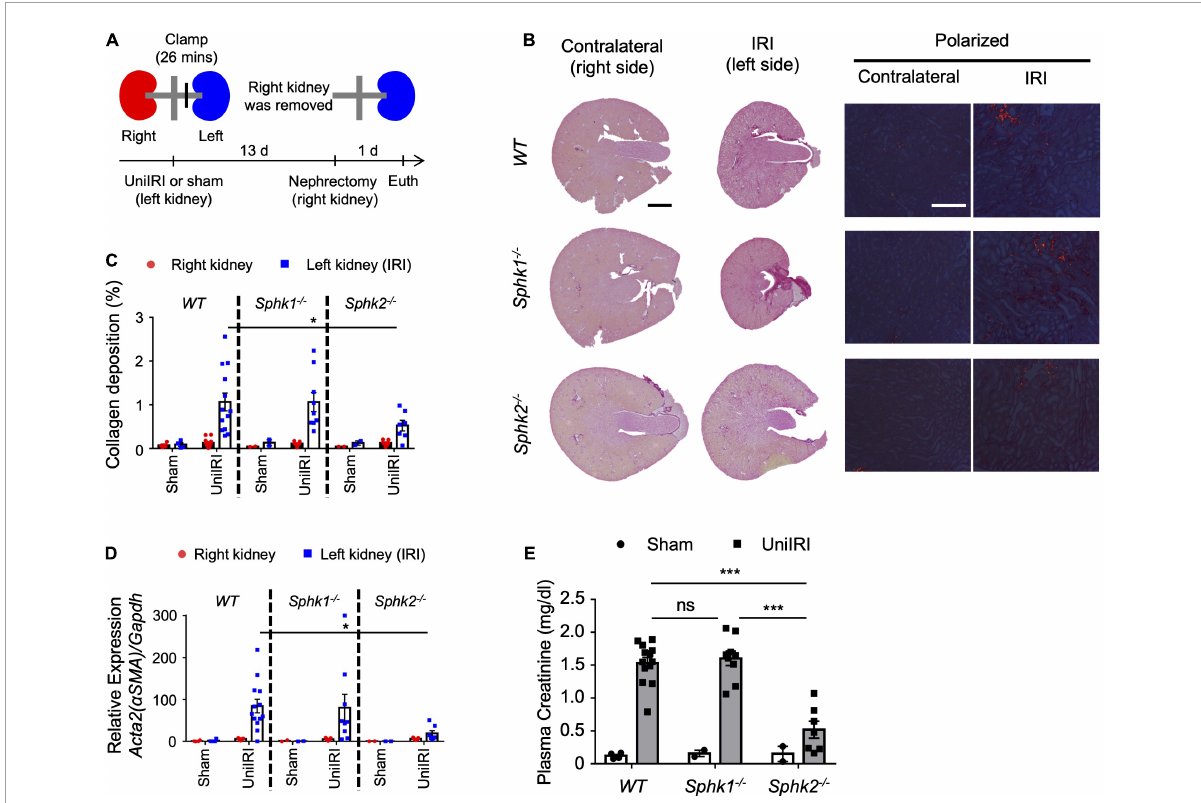
FIGURE1 Sphk2-deficient mice develop less renal fibrosis. (A) Experimental plan for b-e. (b-e) Nephrectomy (right; uninjured kidney) 13 days after renal unilateral (left) ischemia-reperfusion injury (UniIRI; 26 min ischemia); kidney injury evaluated 1 day later. (B) Representative photographs of picrosirius red staining of kidney sections. Interstitial collagen deposition is expressed as the percentage of the kidney tissue section surface area occupied by red/yellow pixels detected under polarized light microscopy. Sphk2 − / − develop less renal fibrosis as shown by tissue morphology (C) , scored from polarized picrosirius red photographs in panel (B) ; % of kidney cross-sectional area) and RT-PCR of fibrosis markers [ (D) RNA from whole kidney], and their kidney function is preserved (E) as indicated by reduced plasma creatinine. n = 7–13 in panels (B–E) . Data were analyzed using one-way ANOVA in panel (E) and two-way ANOVA in panels (C,D) followed by post hoc multiple-comparison test (Tukey’s). * P < 0.05 and *** P < 0.001. In this and subsequent figures, only statistically significant differences of interest are marked. Scale bar = 1 mm in whole kidney, 200 µ m in polarized view in panel (B)